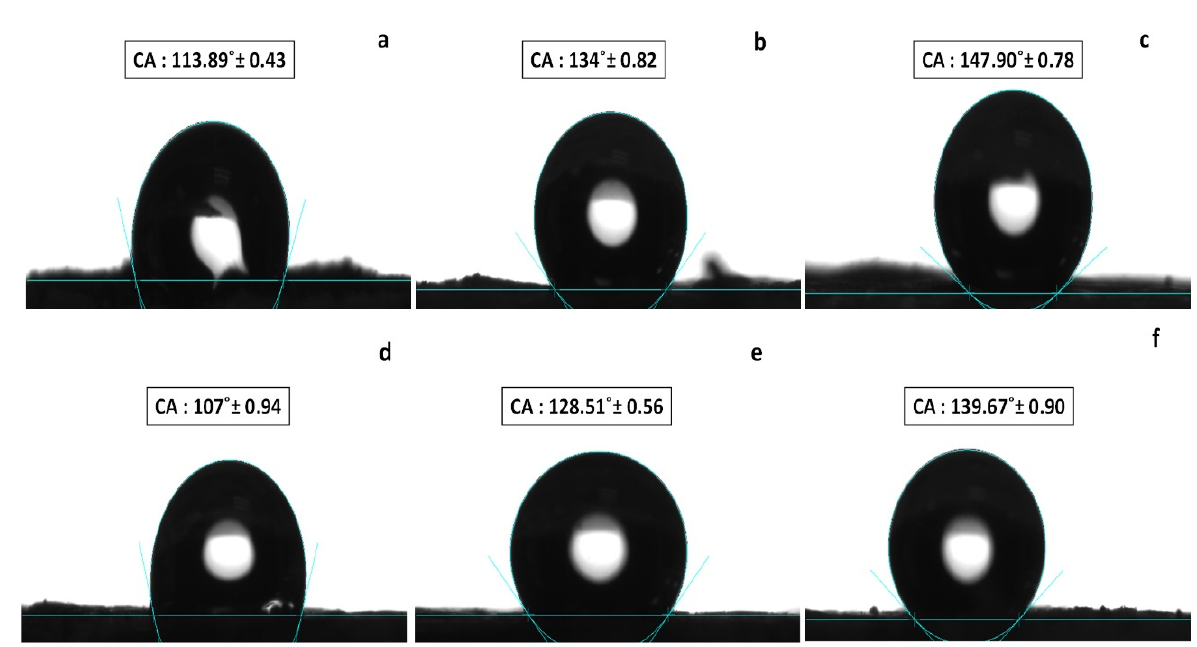
Figure 10. Water contact angles for ( a ) PP10L, ( b ) PP10L-0.1P, ( c ) PP10L-0.3P, ( d ) PP20L, ( e ) PP20L-0.1P, ( f ) PP20L-0.3P. Table 5. The contact angles with water and the surface free energy a.